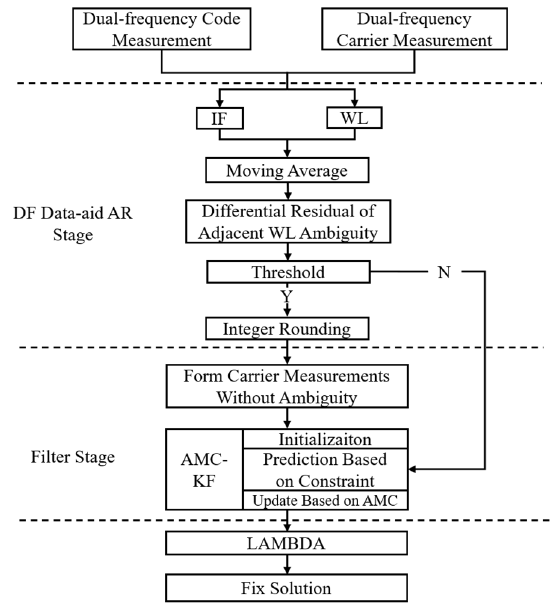
Figure 1. The procedure of the filter